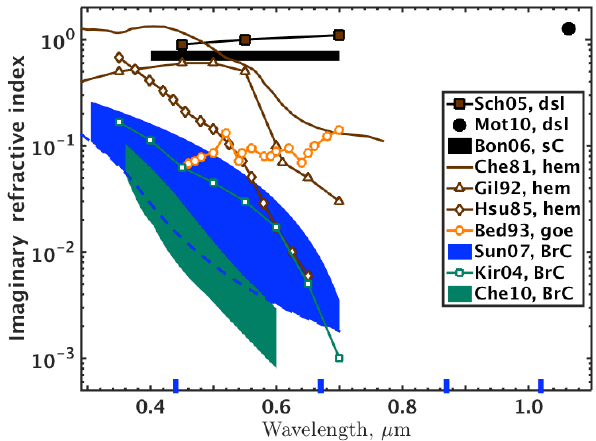
Figure 1. Imaginary refractive index of diesel (dsl), soot carbon (sC), hematite (hem), goethite (goe), and brown carbon (BrC), as measured or inferred by several sources. Thick blue ticks at bot- tom indicate the AERONET retrieval wavelengths. Legend code: Sch05 is Schnaiter et al. (2005); Mot10 is Moteki et al. (2010); Bnd06 is Bond and Bergstrom (2006); Che81 is Chen and Cahan (1981); Gil92 is Gillespie and Lindberg (1992); Bed93 isBedidi and Cervelle (1993); Sun07 is Sun et al. (2007); Kir04 is Kirchstetter et al. (2004); Che10 is Chen and Bond